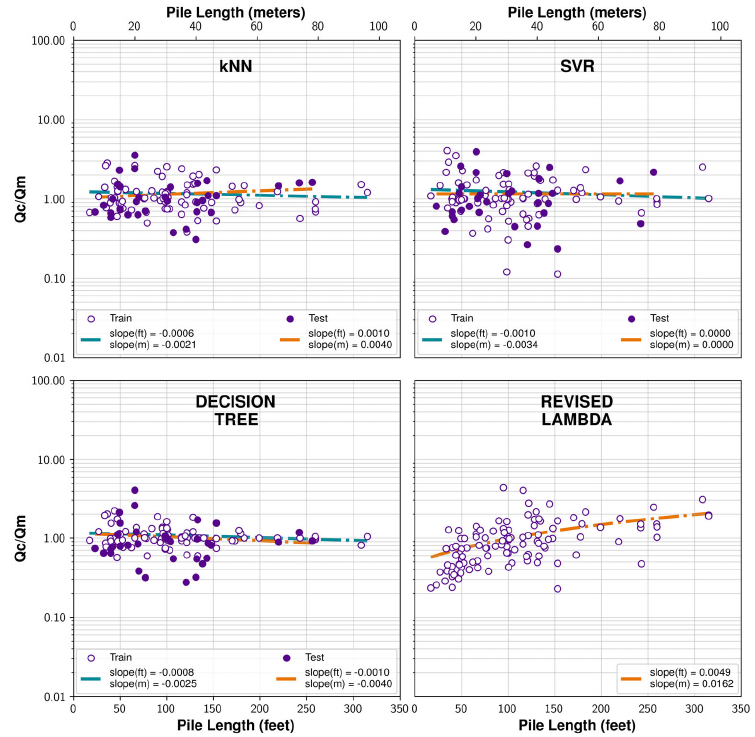
Figure 8. Effect of pile length on the performance of the machine learning models and the Revised Lambda method.